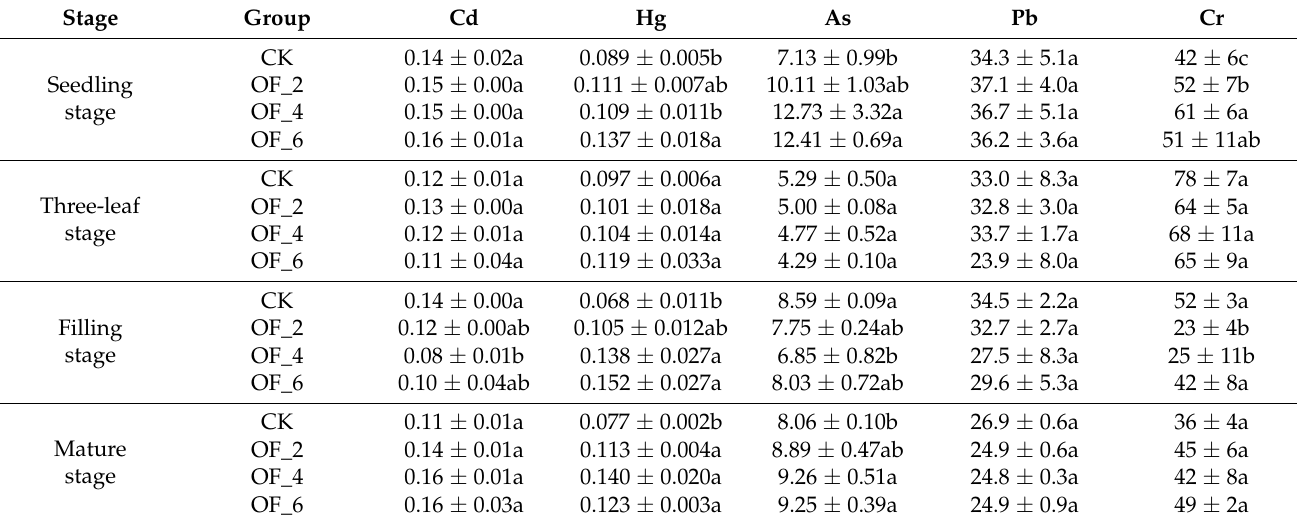
Table 2. Effect of organic fertilizer application rate on soil heavy metal. Units: